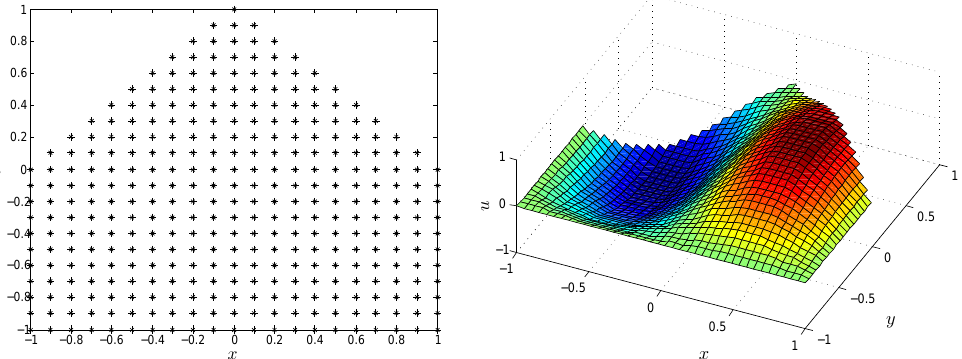
Figure 4. Computational domain x -axis [ − 1,1 ] and y -axis [ − 1,1 ] ( left ) and numerical solution ( right ) for Problem